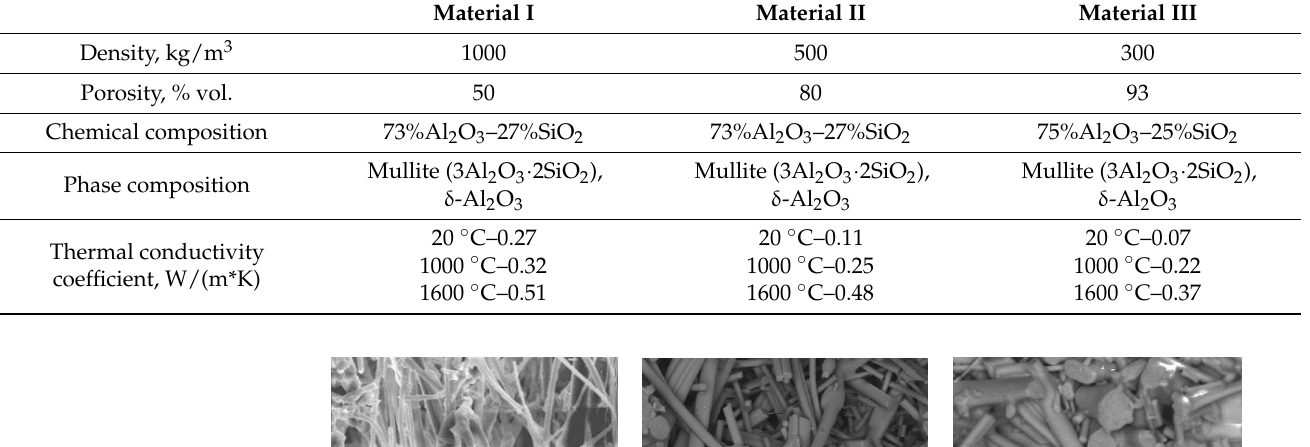
Table 1. The properties of three ceramic composite materials under study before the experiment.